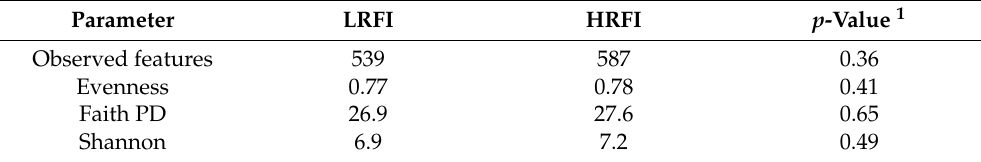
Figure 5. Box plots showing number of features. Data are shown for both day of sampling and DNA extraction method. The number of features and all other alpha diversity metrics were significantly higher using samples from method A with no significant differences between LRFI and HRFI. Table 4. Mean alpha diversity parameters from method A using the filtered table. Table 5. Mean alpha diversity parameters from method B using the filtered